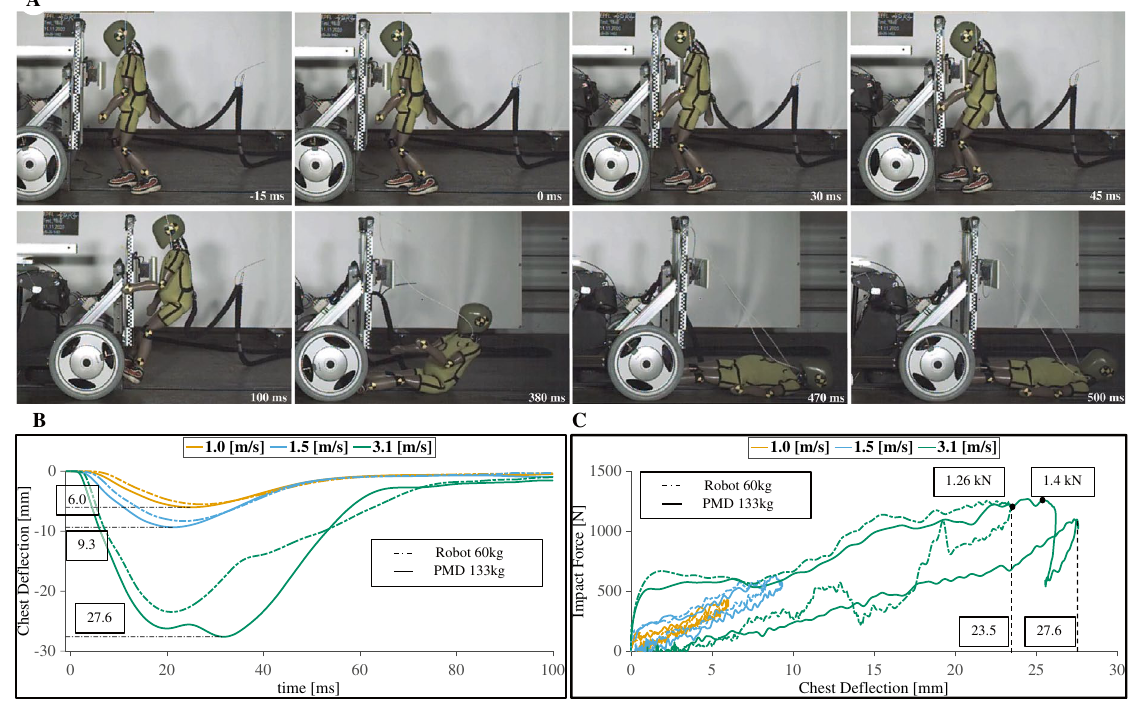
Figure 3. Child pedestrian injuries from a thoracic-level impact. ( A ) Time-lapse of a mobile service robot (mass of 60 kg) colliding with a 15-kg child dummy with the impact set at the chest (0.57 m from the floor). ( B ) Internal chest deformation as measured within the dummy, with a maximum deformation of 27.6 mm at 3.1 m/s (11.1 km/h/6.9 mph), equivalent to a 50% risk of serious injury. ( C ) Impact force-to-deformation ratio during the first 100 ms of the collision, showing a corridor of deformation proceeding the